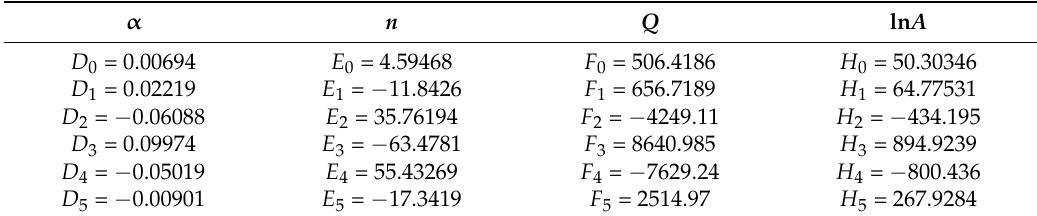
Figure 12. Variation of ( a ) α , ( b ) n , ( c ) Q and ( d ) ln A with ε . Table 3. Polynomial coefficients for α , n , Q , ln A for 800–900 ◦ C.